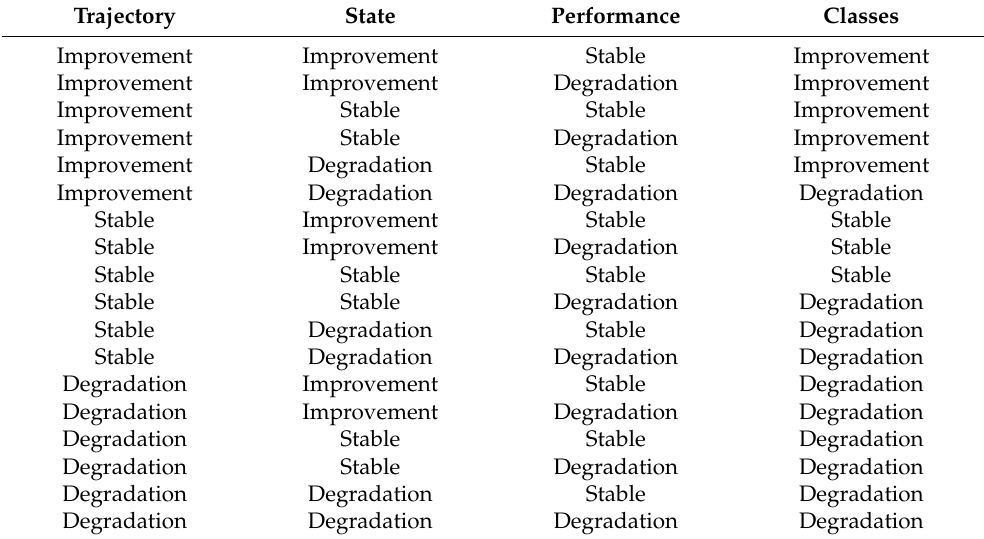
Table A1. Aggregating the productivity sub-indicators.